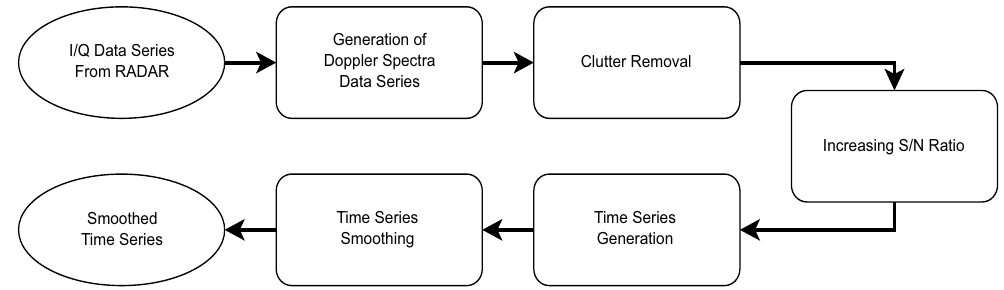
Figure 3. Flow chart describing the main processing stages.